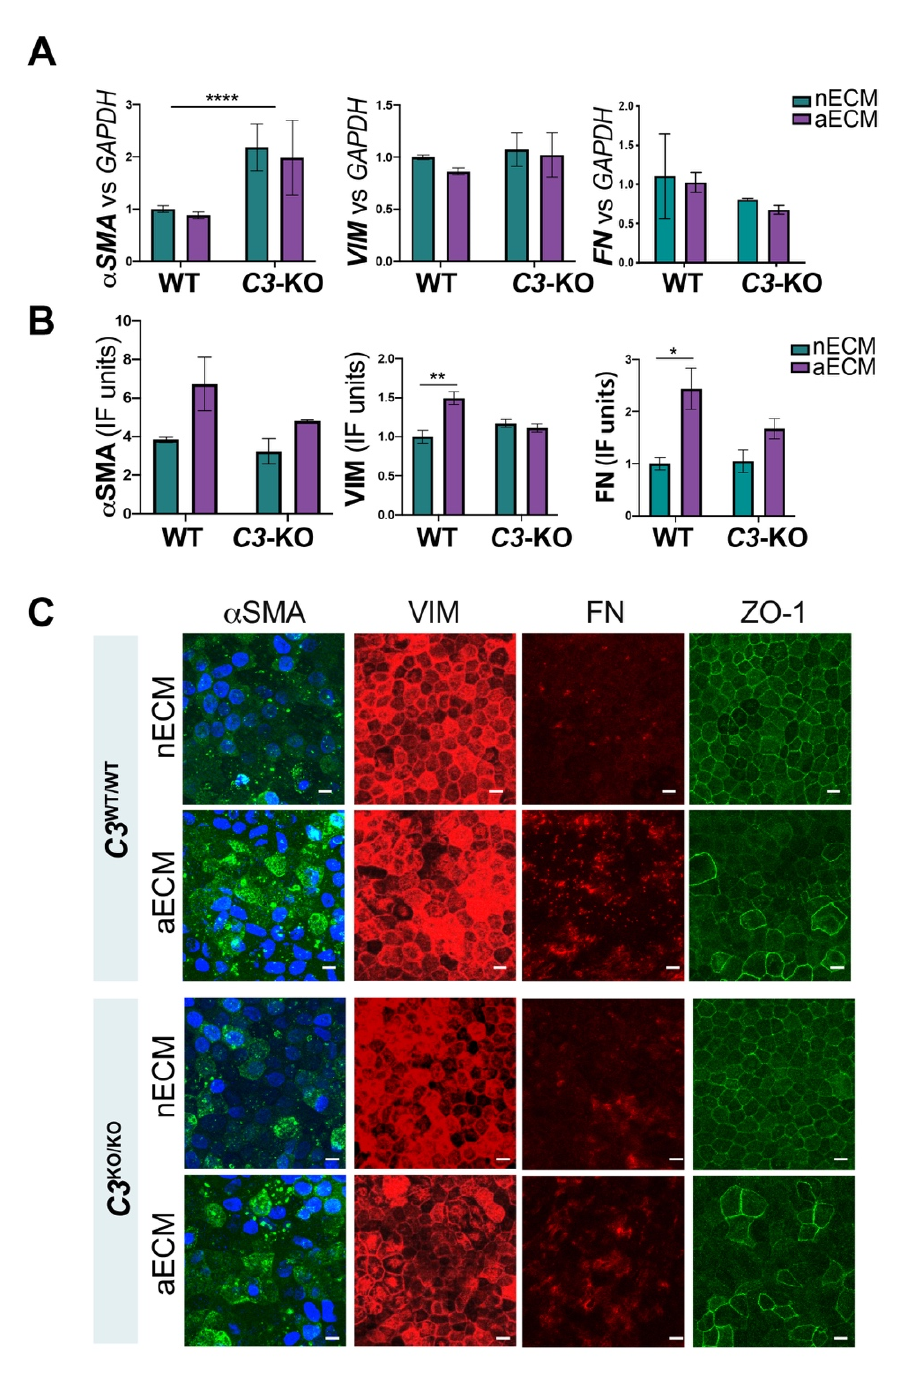
Figure 4. AMD-like substrate triggers EMT in iPSC-RPE cell cultures. ( A ) mRNA levels of α SMA , VIM and FN normalized to GAPDH measured in iPSC-RPE cultures C3 WT/WT and C3 KO/KO grown on transwells coated with nECM and aECM after 20 weeks. ( B ) Quantification of expression of α SMA, VIM, and FN in the same cultures was carried out combining the fluorescent signal of all z-stacks measured in different areas of the transwell after immunostaining with antibodies. Data was normalized to cell counts. (Data represented as mean ± SD, n = 3. 2-way ANOVA, **** p < 0.0001, ** p < 0.01, * p < 0.05). ( C ) Representative confocal fluorescent pictures of iPSC-RPE cultures C3 WT/WT and C3 KO/KO grown on transwells coated with nECM or aECM for 20 weeks. Immunostaining with antibodies for α SMA , VIM, FN and ZO-1 indicated that wild type and mutant cells cultured on aECM undergo EMT. Scale bars: 10 µm.